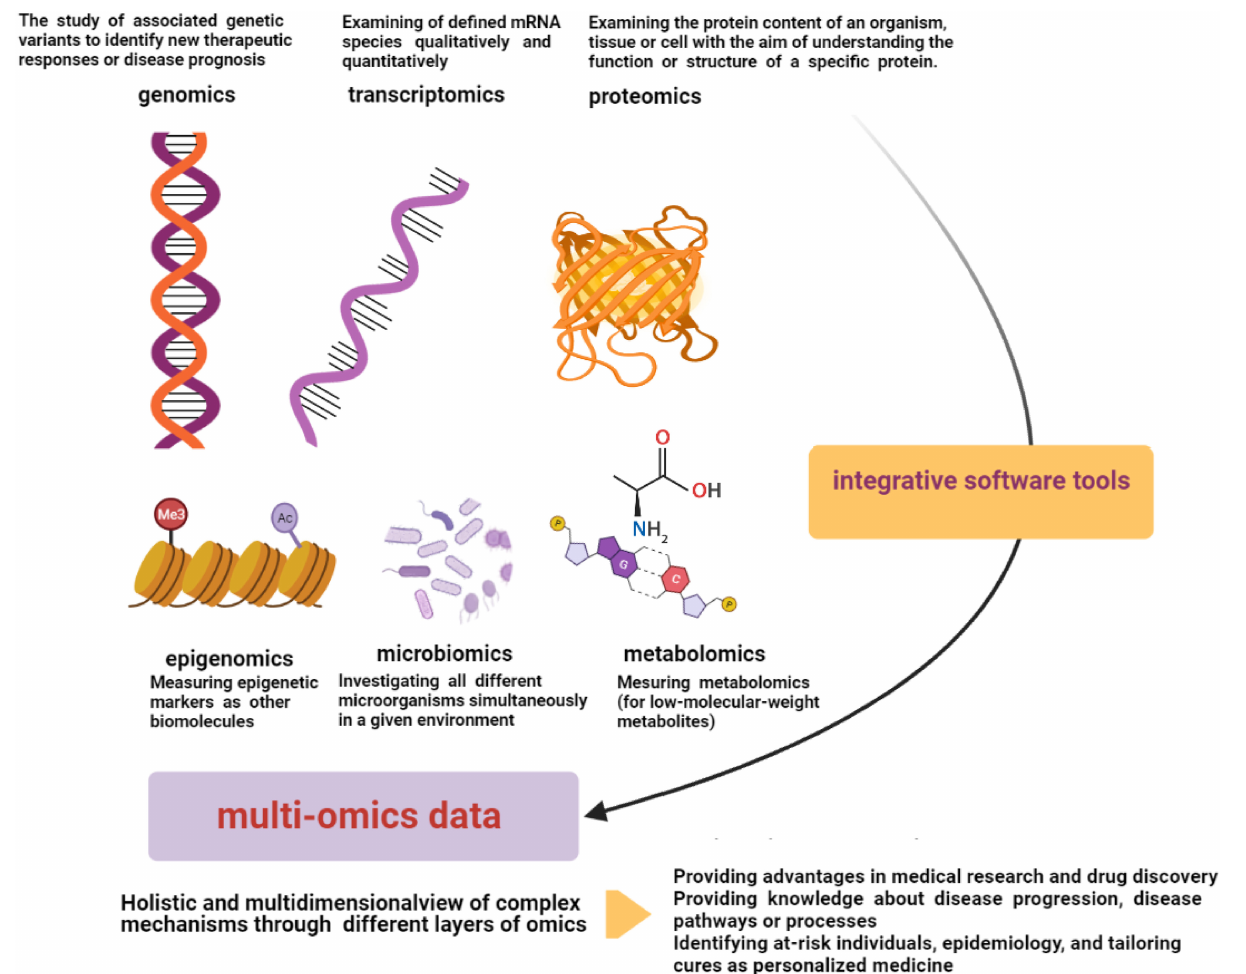
FIGURE 2 | Multi-omics data. Multi-omics technologies through different layers of omics data (genomics, transcriptomics, microbiomics, proteomics, epigenomics, and metabolomics) can provide a multidimensional analysis network to develop knowledge of interactive molecular basis and complex underlying pathophysiology of disorders. Electronic health records, imaging, and other integrative software tools can be helpful in integrative processes (Sun and Hu, 2016; Hasin et al.,